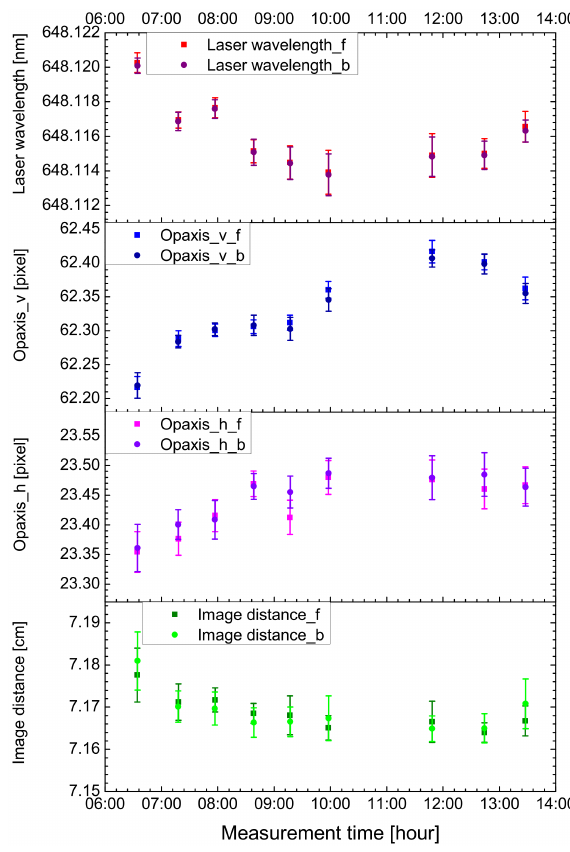
Figure 20. Variation of the spectral calibration parameters over time during the HALO flight on 13 September